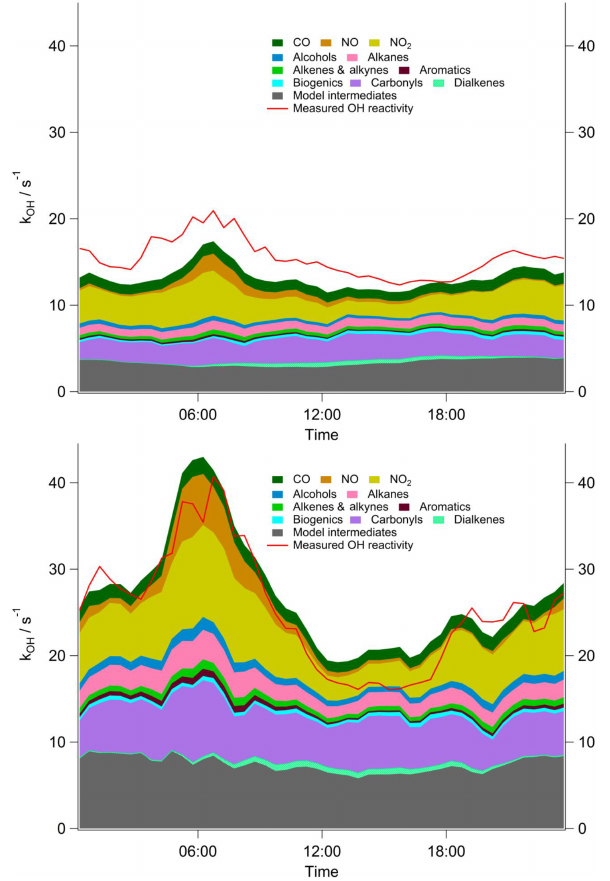
Figure 6. Average diurnal profile of measured reactivity and a breakdown of modelled reactivity into inorganic and organic classes when the model is constrained to the standard VOC suite measured by the dual-channel (DC)-GC-FID, additional VOCs (including α - pinene and limonene; see Table 1 for details) measured by GC GC- × FID and unassigned GC GC-FID peaks. Top: average diurnal dur- × ing south-westerly flows and bottom: average diurnal during east- erly flows.